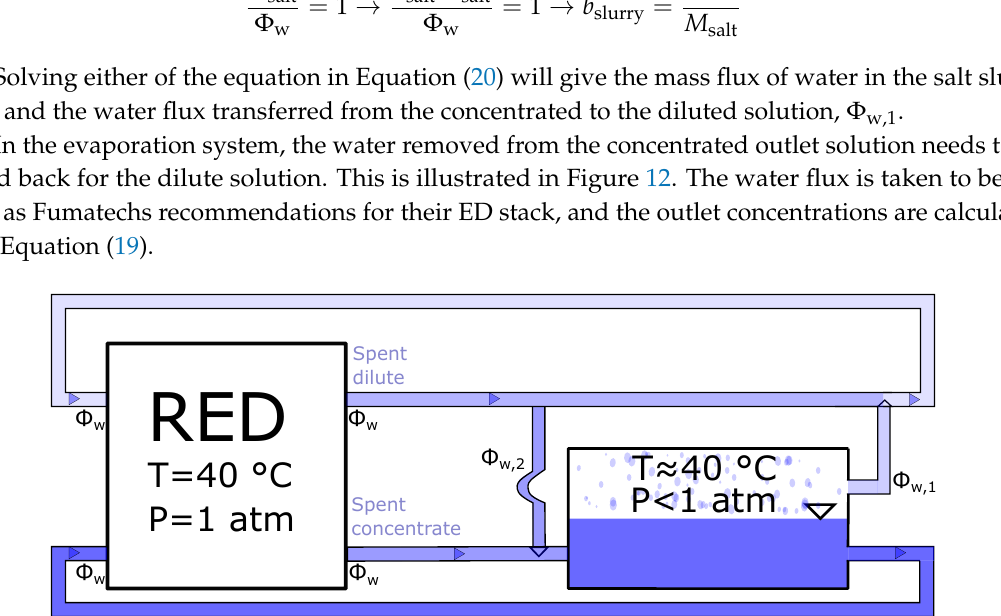
Figure 12. The mass flow in the evaporation system. Φ w,1 is the water flow from concentrated to the dilute solution, while Φ w,2 is the water flow from the dilute to the concentrated solution. For no loss of water, Φ w,1 ≡ Φ w,2